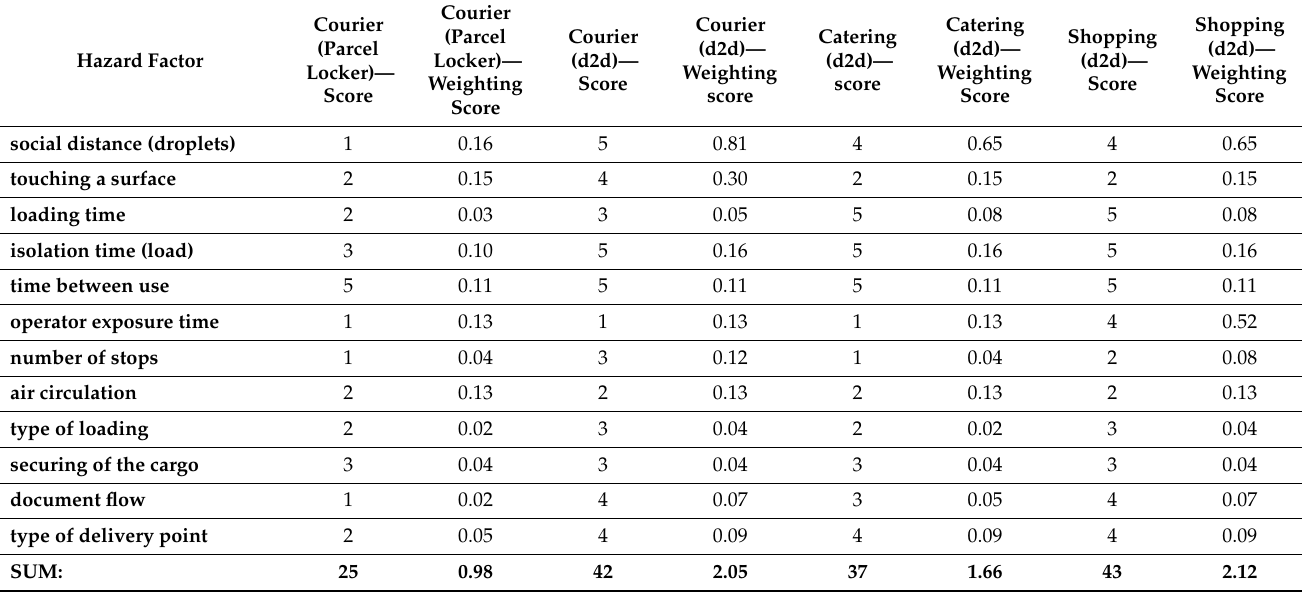
Table 7. Comparison of total assessment and weighted assessment of epidemic